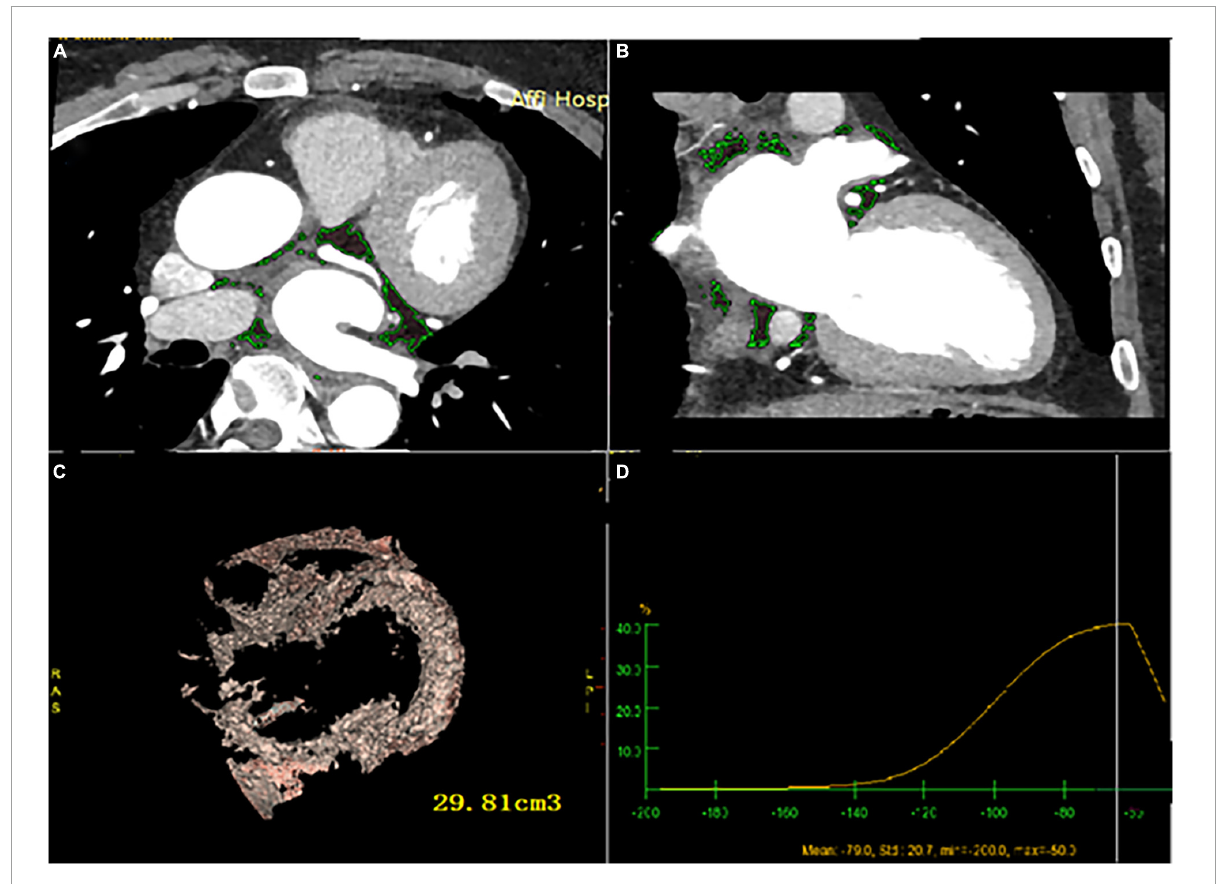
FIGURE3 LA-EAT volume and attenuation calculated by post-processing software (A) cardiac axial map; (B) cardiac coronal map; (C) yellow area represents LA- EAT, and the volume is calculated by Volume software; (D) LA- EAT attenuation.